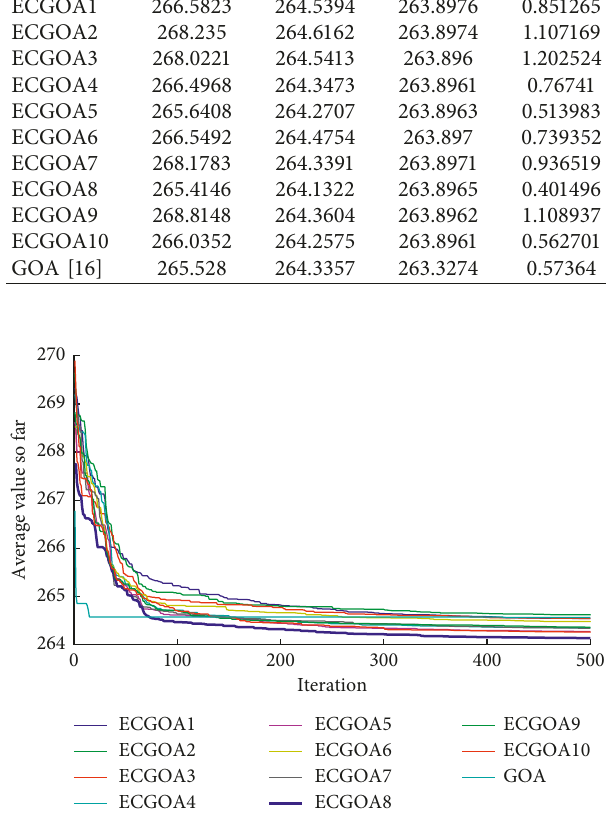
Figure 8: Convergence curve for three truss bar design